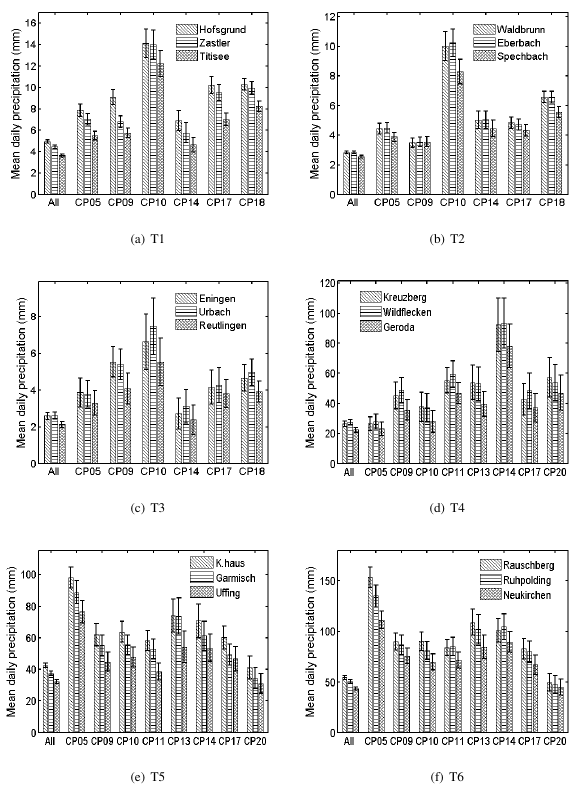
Fig.14. MeanprecipitationofeachwetCPfortheselectedstationgroups Fig. 14. Mean precipitation of each wet CP for the selected station groups.